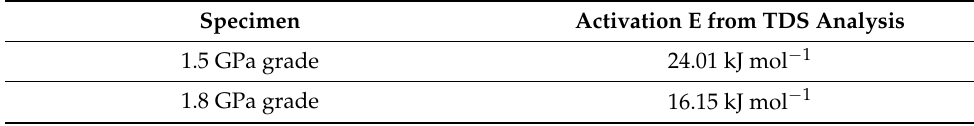
Table 6. Activation energy of diffusible hydrogen under 573 K in the studied alloys.